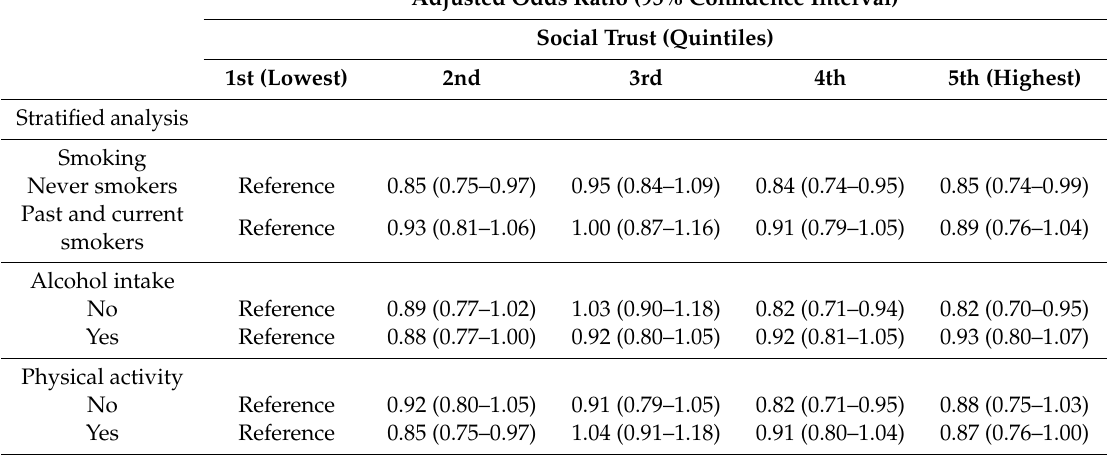
Table 4. Stratified analyses on the association of social trust with metabolic syndrome, taking into consideration smoking, alcohol intake and physical